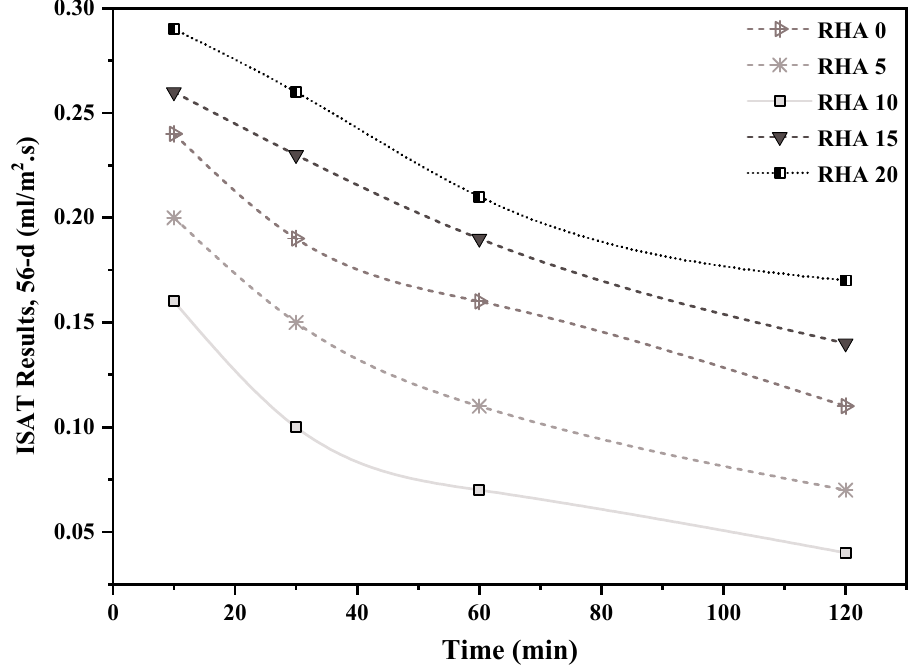
Figure 13. ISAT results, after 56 days, of concrete incorporating different percentages of RHA.